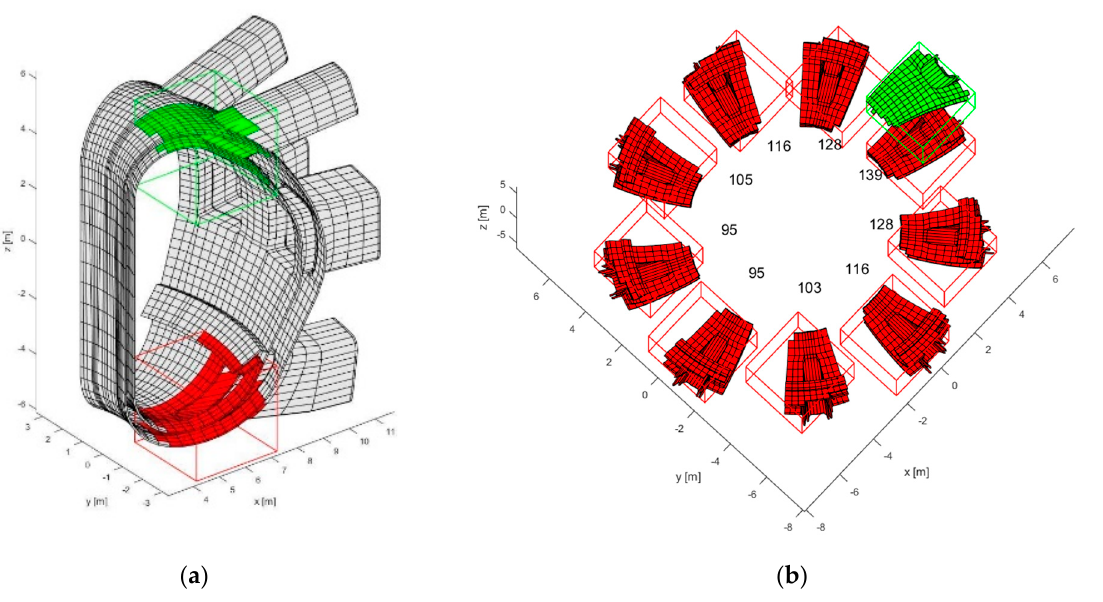
Figure 7. ( a ) The main sector mesh ( −20° < 𝜑 < 20° ), and the source (red) and field (green) box, ( b ) For each sector ( 𝑗 = 1, 9 ) we show the replicated mesh, and we report besides the rank of the matrix ( b ) For each sector ( j = 1,9) we show the replicated mesh, and we report besides the rank of the matrix 𝐋 𝐛𝐜 ((cid:2920)) between the source box (red) and the field box (green). L bc ( j ) between the source box (red) and the field box